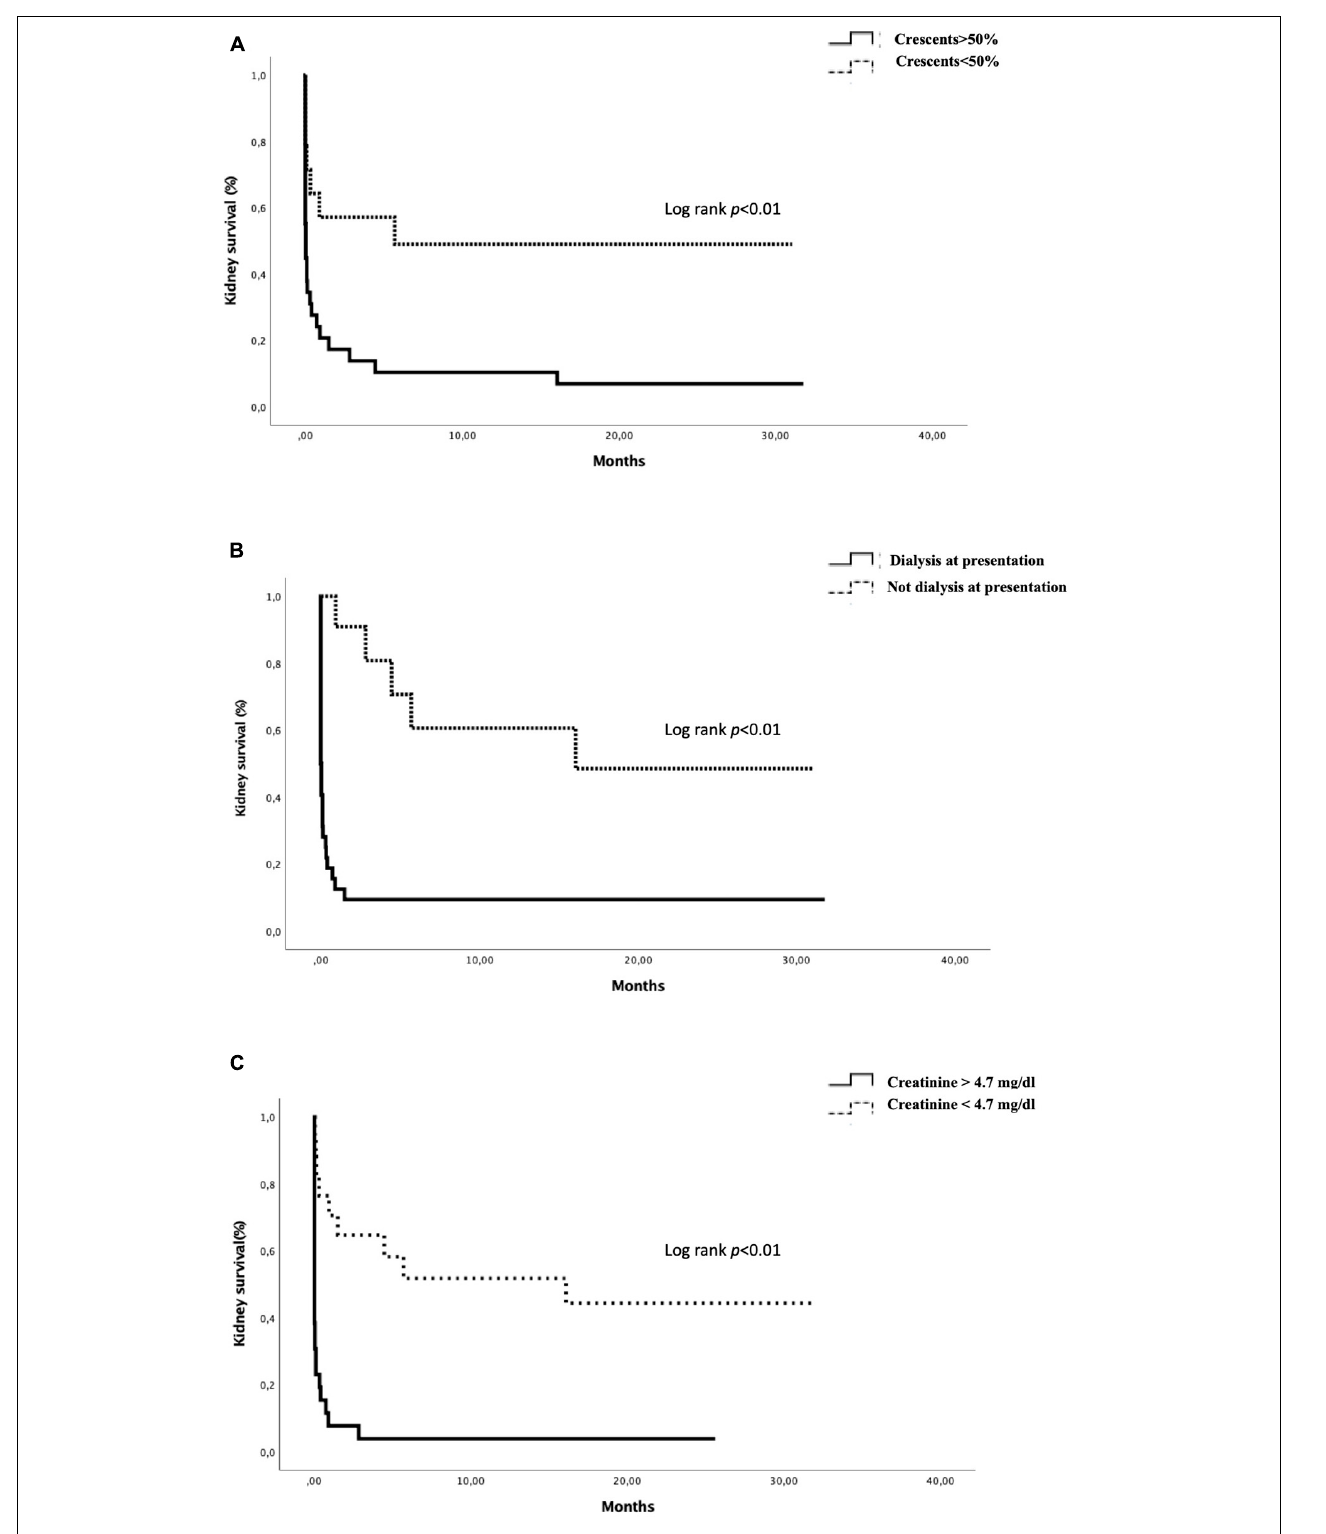
FIGURE 2 | Actuarial renal survival by Kaplan–Meier curve according to the presence of > 50% of crescents (A) , dialysis at presentation (B) , and creatinine > 4.7 mg/dl (C) .